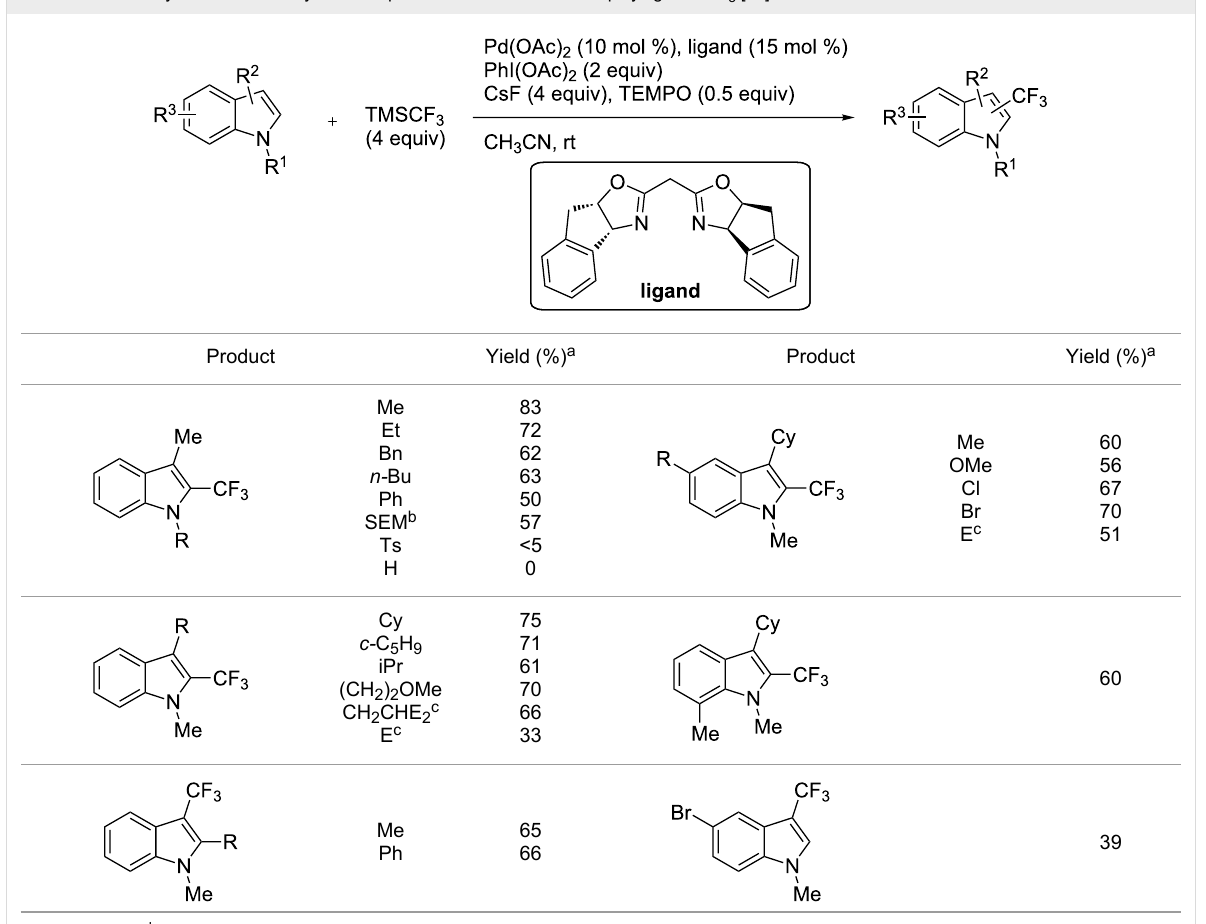
Table 10: Pd-catalyzed trifluoromethylation of sp 2 -C–H bonds of indoles employing TMSCF 3